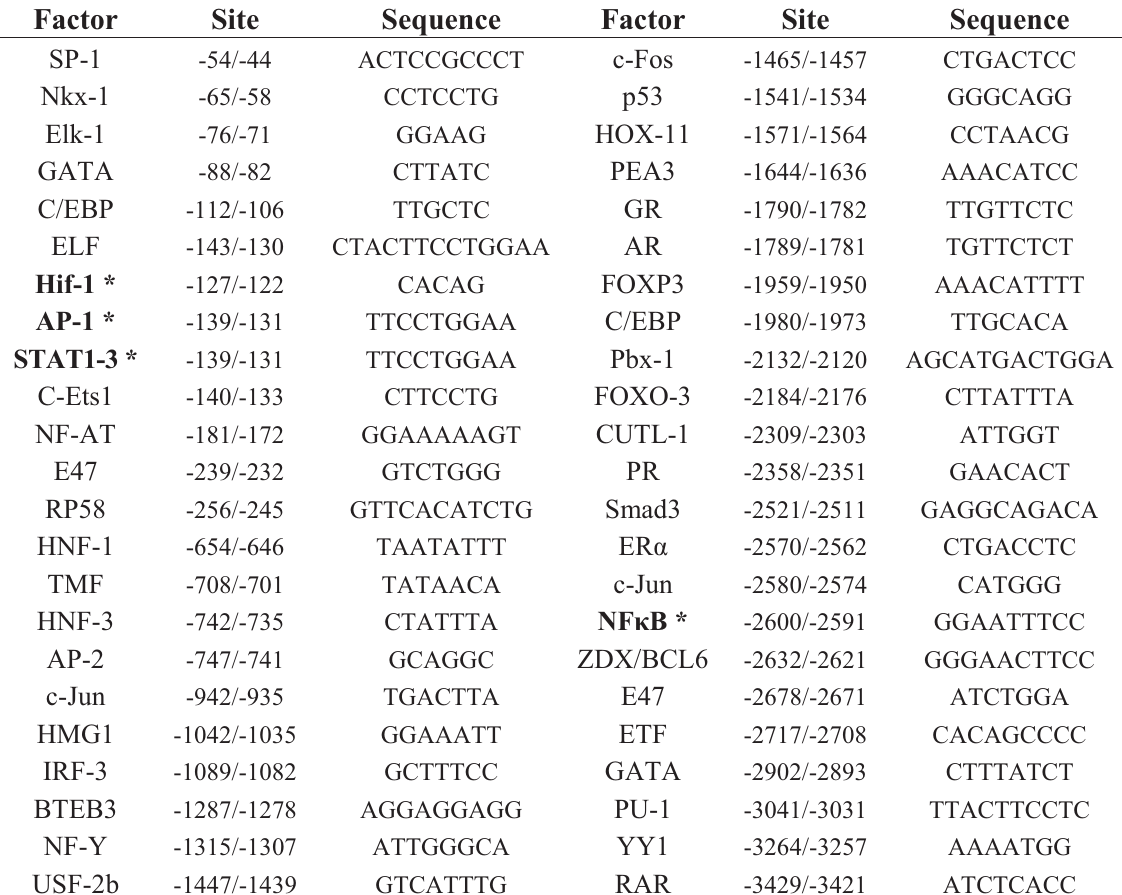
Table 2. List of putative transcription factor binding sites in human CCL2